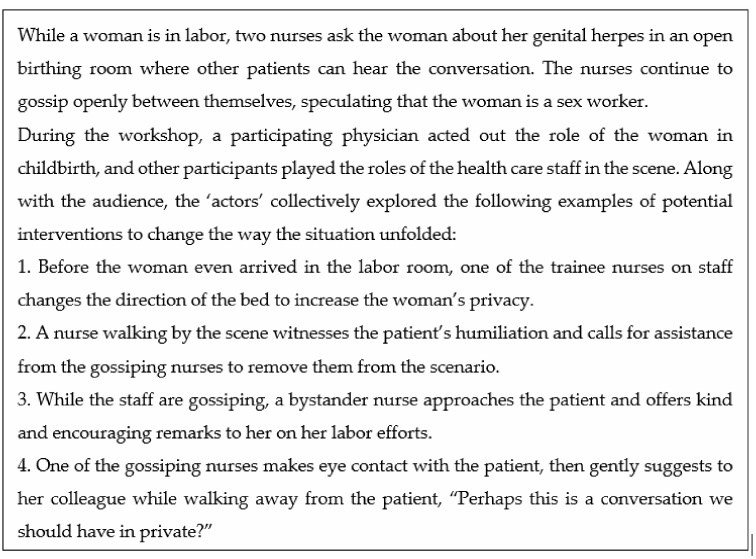
Figure 1. Example of a situation described by participants as illustrative of abuse in health care, and suggested solutions explored during the